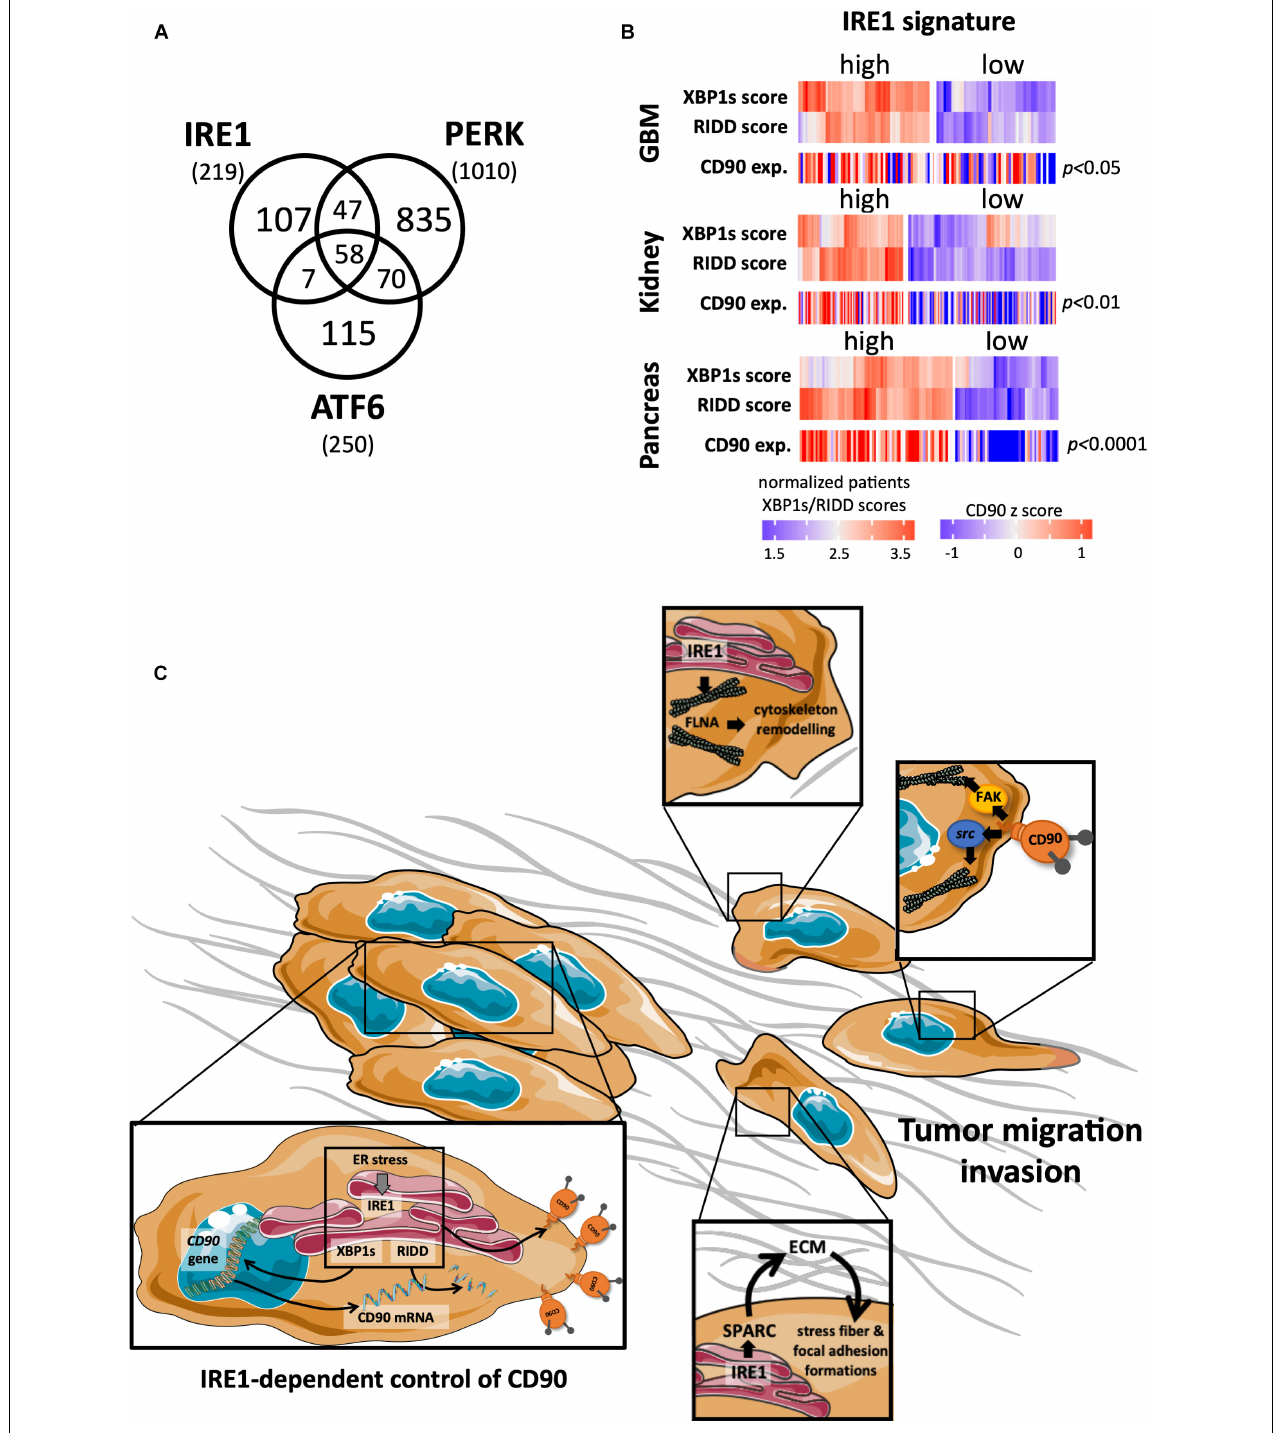
FIGURE 3 | Links between CD90 and IRE1 activity in cancers. (A) Articles describing a role for the ER stress sensors IRE1, PERK, and ATF6 in human cancer disease were collected using Pubmed and their distribution represented per sensor type. (B) CD90 mRNA expression was analyzed according to IRE1 activity from GBM, kidney and pancreas cancers (TCGA resources). Cancer patients were classified in regard to IRE1 and XBP1s/RIDD activities as described in Lhomond et al. (2018). (C) A schematic representation of the possible CD90 regulation by IRE1 is presented.